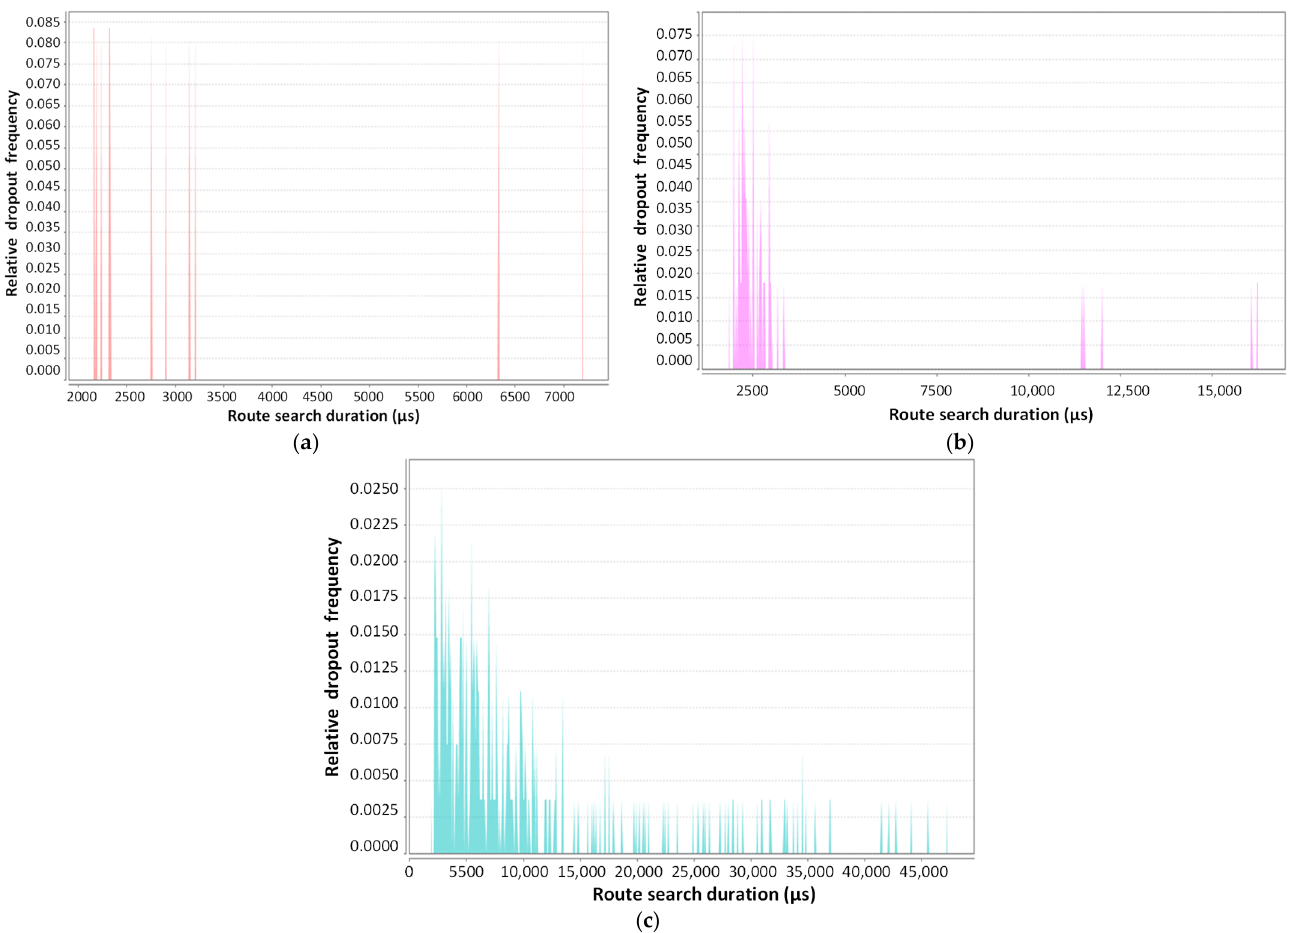
Figure 14. Estimation of the route search duration for ( a ) 4 nodes ( b ) 8 nodes ( c ) 18 nodes of the network using the standard k-means clustering algorithm.